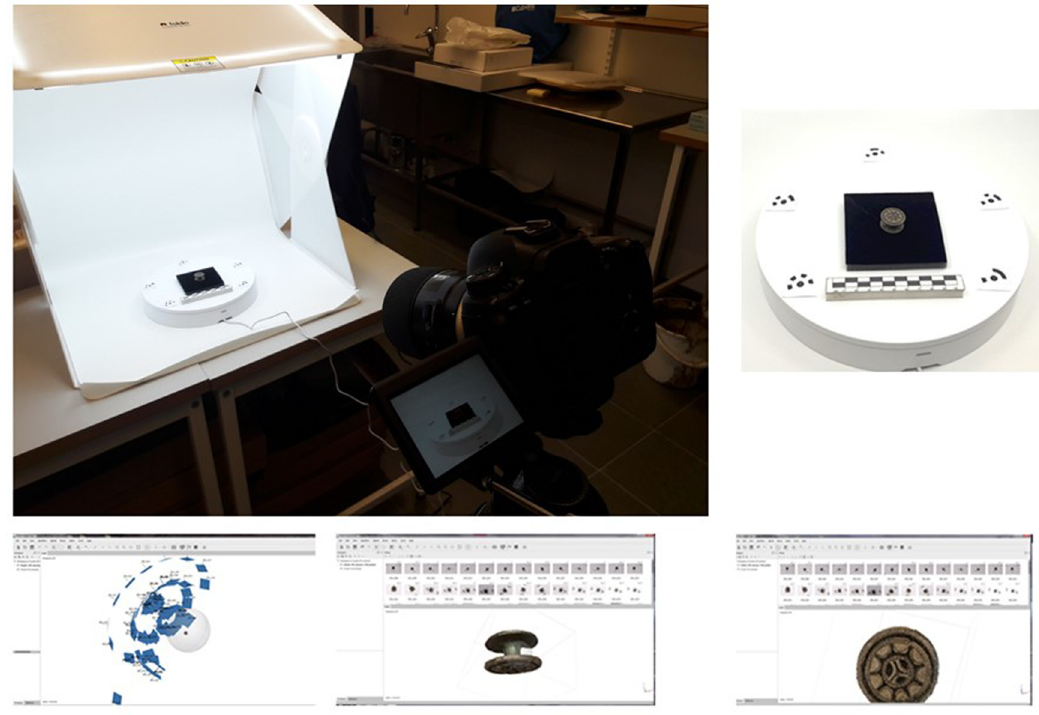
Figure 2: The acquisition of a Bronze Age double button using